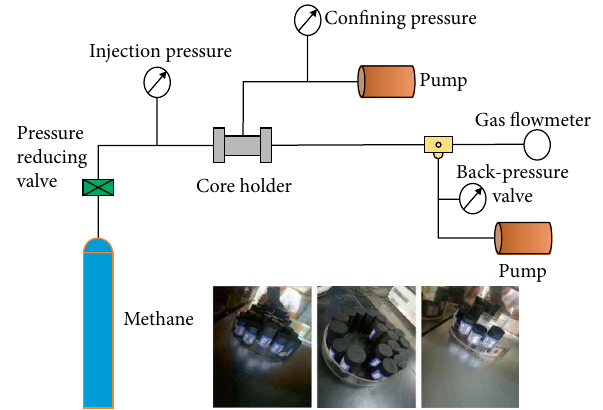
Figure 3: Schematic of TPG experimental equipment and core